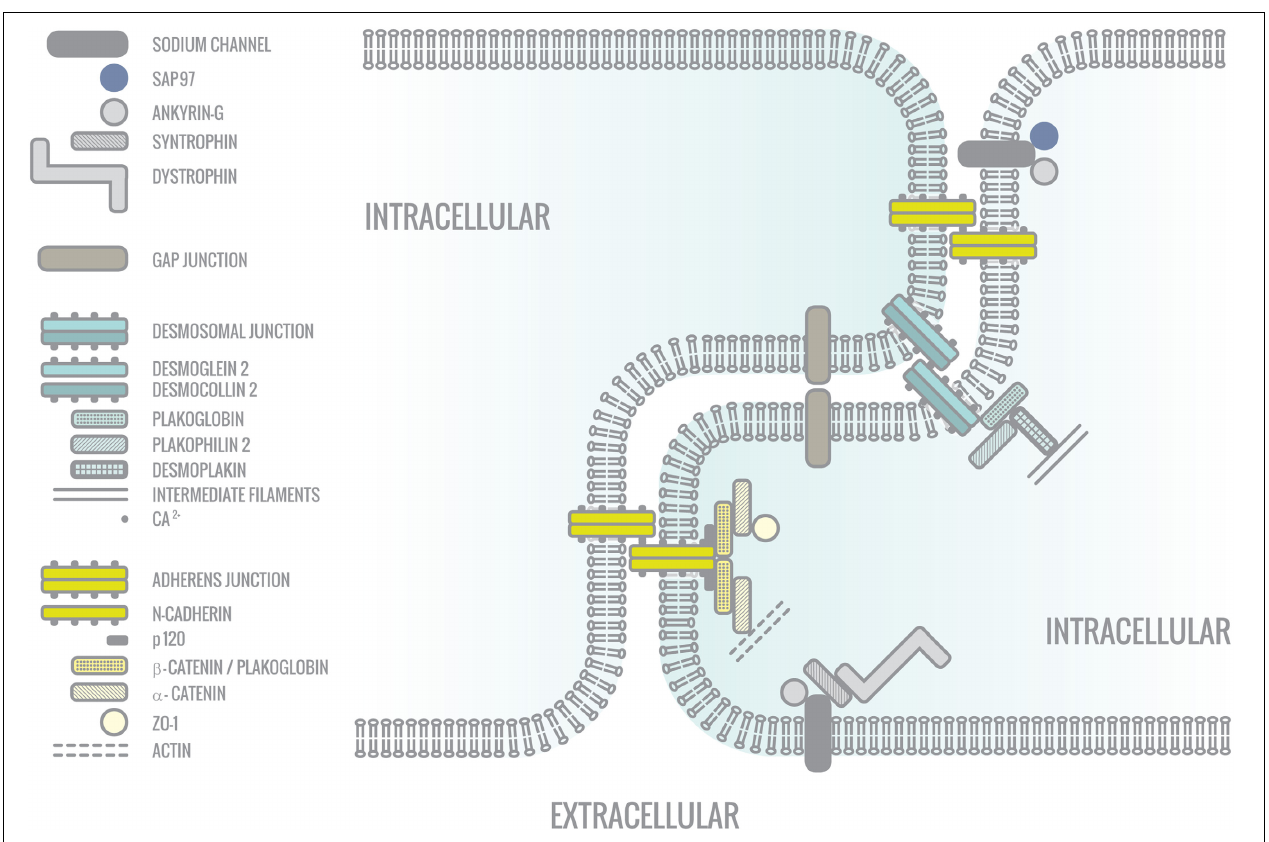
FIGURE 2 | The intercalated disc (ICD). The intercalated disc is the region between two cardiomyocytes, where different junctions are located: Gap junctions, adherens junctions, and desmosomal junctions as well as ion channels. They all form macromolecular protein complexes with different functions.